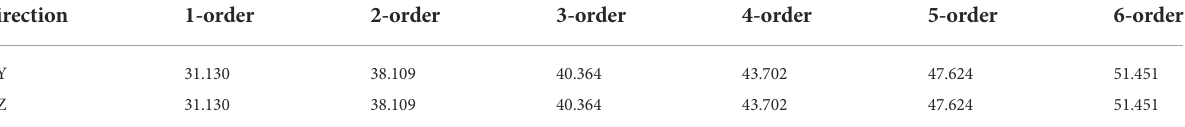
TABLE 4 Frequency of M310/hz.